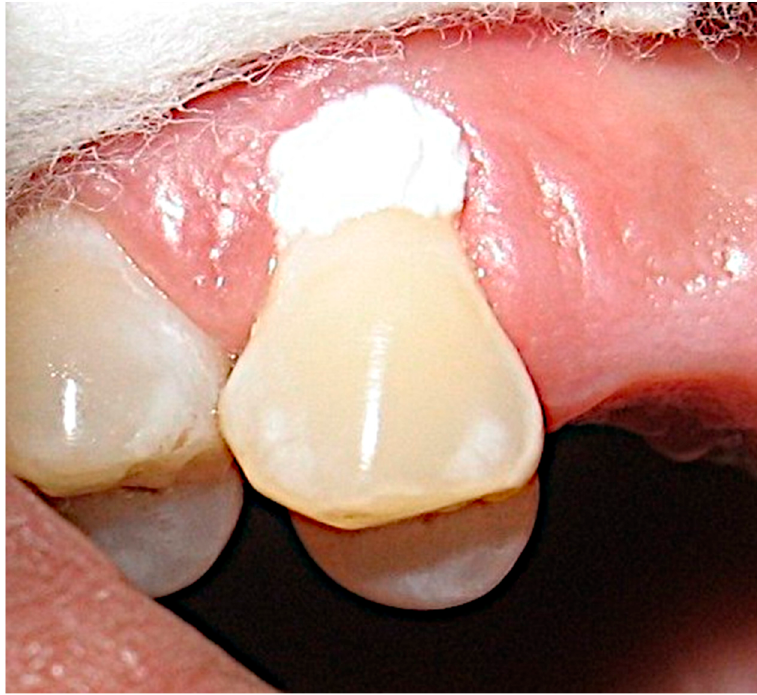
Figure 4. Application of the NovaMin ® paste on the most sensitive tooth.